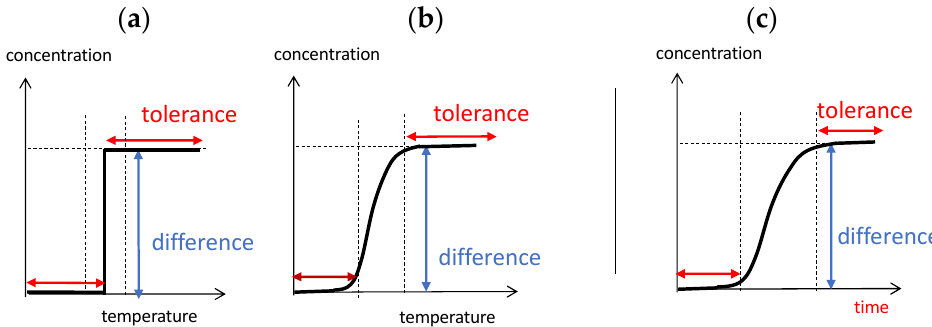
Figure 5. Limit states of ( a ) the Heaviside step relationship and ( b ) sigmoidal relationship out of chemical equilibrium shown by concentration/temperature profiles. ( c ) Sigmoidal kinetics shown by concentration/time profiles. Dotted lines indicate differences in concentration against a temperature change.